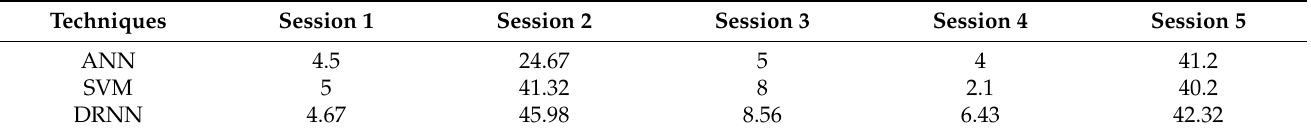
Figure 7. Comparative analysis between existing and proposed classification techniques for varying sessions. Table 3. Prediction performance under various sessions.